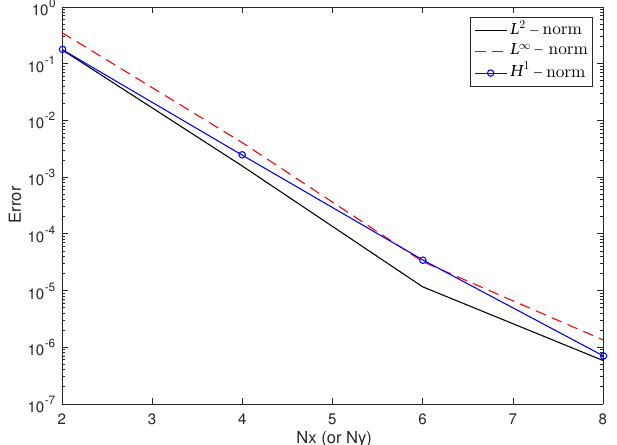
Figure 1. For α = 0.5, β = 0.5, τ = 0.0001, T = 1, the L ∞ , L 2 and H 1 errors show an exponential decay with N x , N y .